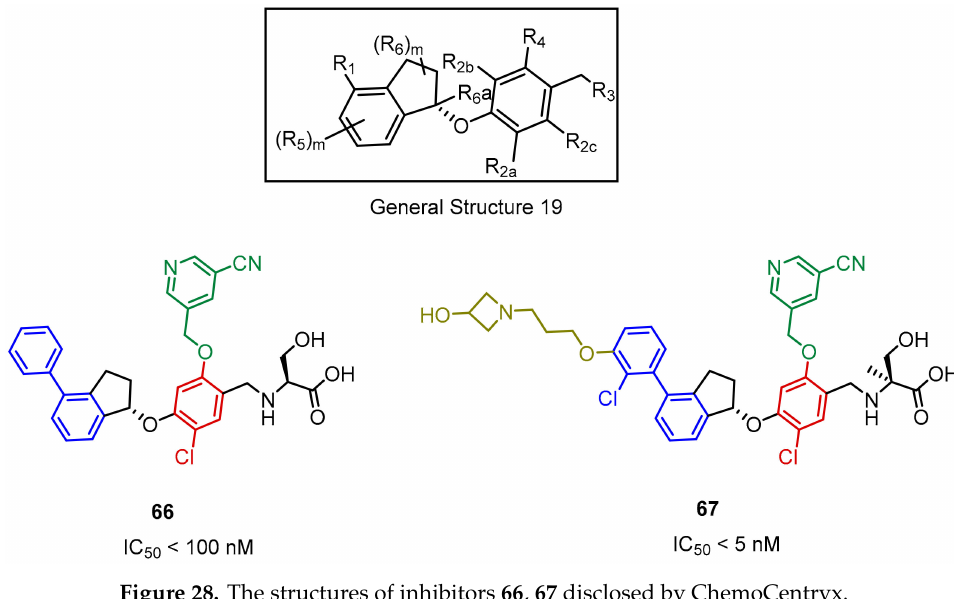
Figure 28. The structures of inhibitors 66 , 67 disclosed by ChemoCentryx.